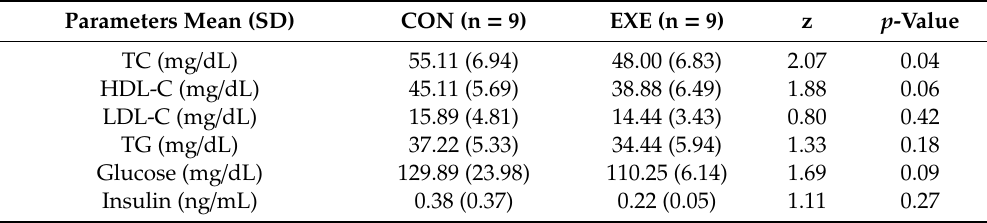
Table 2. Comparison of lipid profiles between the control and exercise group.